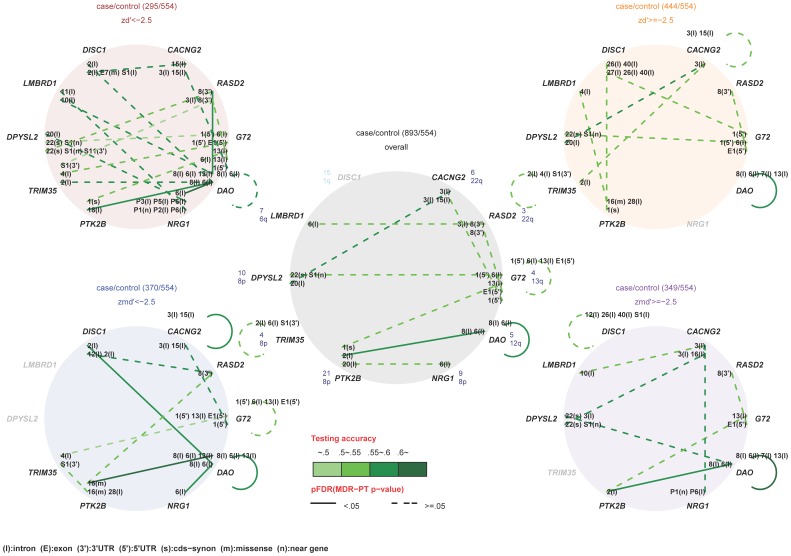
Within-gene and between-gene interactions in schizophrenia for the unstratified and CPT-stratified interaction analyses.The unstratified interaction plot is at the center, and the CPT-stratified plots with the stratum name are located in the four corners. Stratum name and sample size of cases and controls are provided in the title for each panel. Gene name, the number of SNPs in the gene, and the located chromosome are provided around each circle. If an interaction was identified, the SNP id along with its location in the gene (in parentheses) are provided. Abbreviations for SNP locations are: 3′, 3′ untranslated region; 5′, 5′ untranslated region; I, intron; E, exon; s, synonymous SNP; n, near-gene SNP; m, missense SNP. Interaction candidates with a pFDR <0.05 and ≥0.05 are connected by a solid line and dashed line, respectively, and the level of testing accuracy is represented by the line color from light green (less accurate) to dark green (highly accurate).